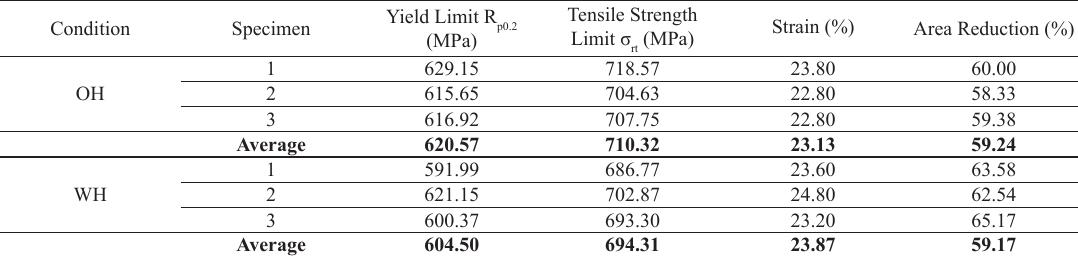
Table 10. Mechanical properties of the base metal (ASTM A182 F22 steel) without (OH) and with (WH) hydrogenation. Condition